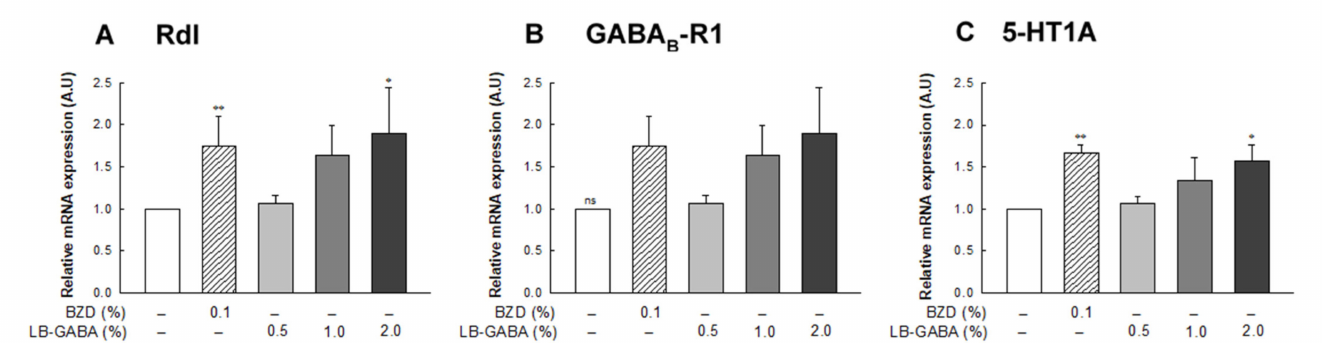
Figure 5. Effects of Lactobacillus -fermented γ -aminobutyric acid (LB-GABA) on mRNA expression of GABAergic and serotonergic receptors in fruit flies. Total RNA was extracted from heads of flies maintained on 12-h light/dark cycle for 2 weeks. Target mRNA was analyzed via quantitative real-time PCR. ( A ) resistance to dieldrin (Rdl), ( B ) GABA B -R1, ( C ) 5-hydroxytryptamine 1A (5-HT1A). Values are the means ± standard deviation (SD) from 150 fruit flies per group; * p < 0.05, ** p < 0.01 versus normal control group according to Tukey’s multiple comparison test. A.U: arbitrary